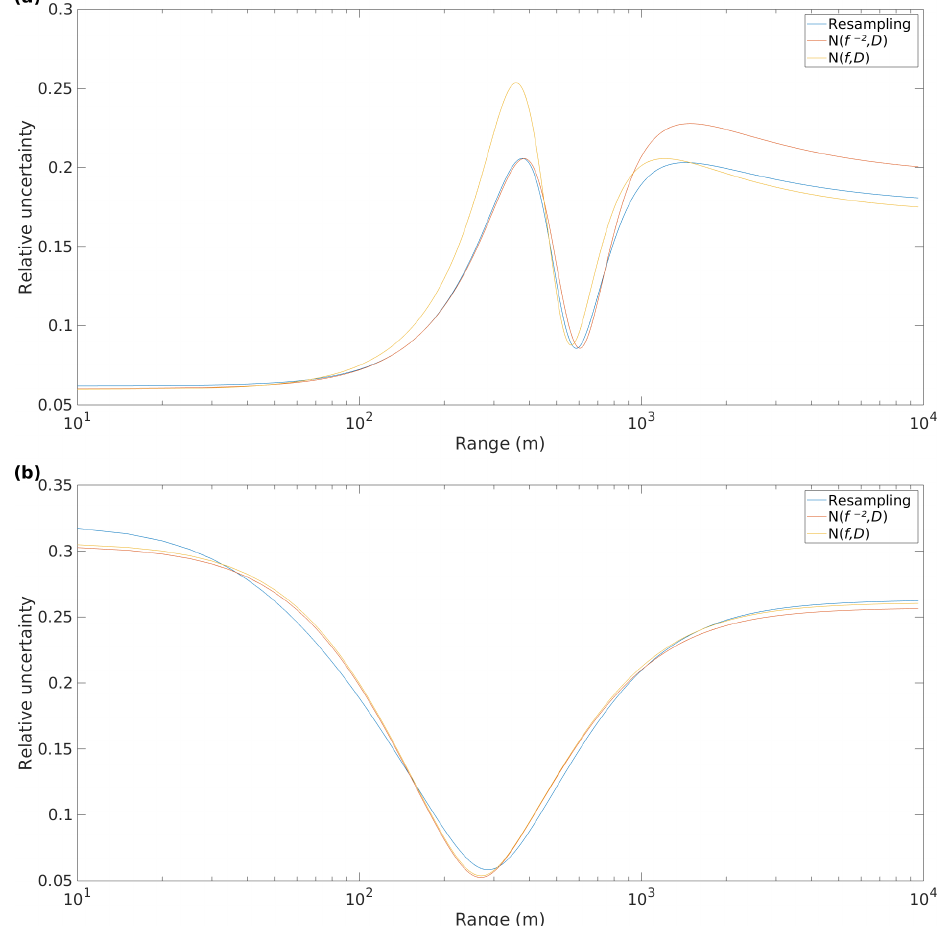
(R) , generated using MCS with three different sets of input values for (a) Darwin f